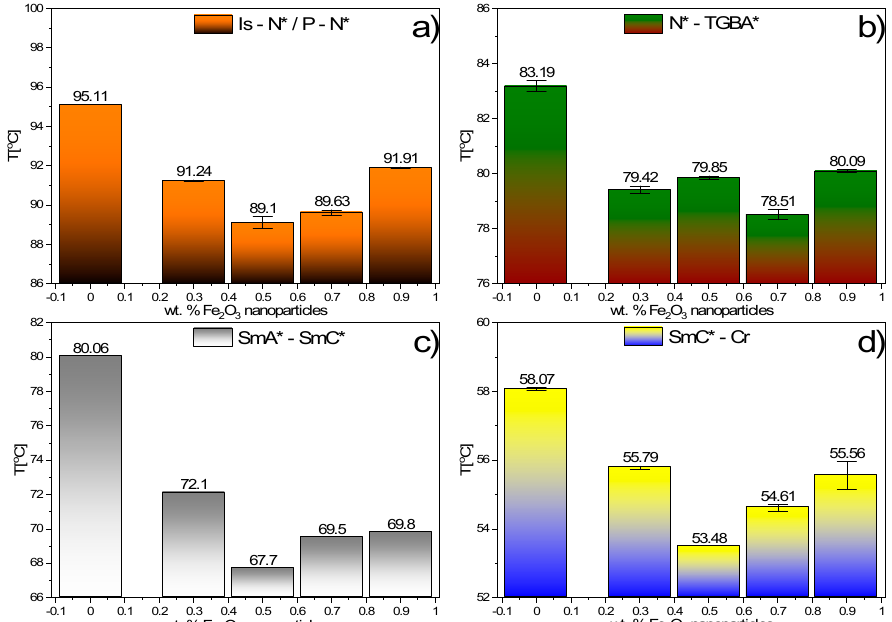
Figure 9. Influence of Fe 2 O 3 nanoparticles admixture on the phase transitions during cooling: Is– N*/P–N* ( a ), N*–TGBA* ( b ), SmA*–SmC* ( c ) and SmC*–Cr ( d ). Is–N*/P–N* ( a ), N*–TGBA* ( b ), SmA*–SmC* ( c ) and SmC*–Cr ( d